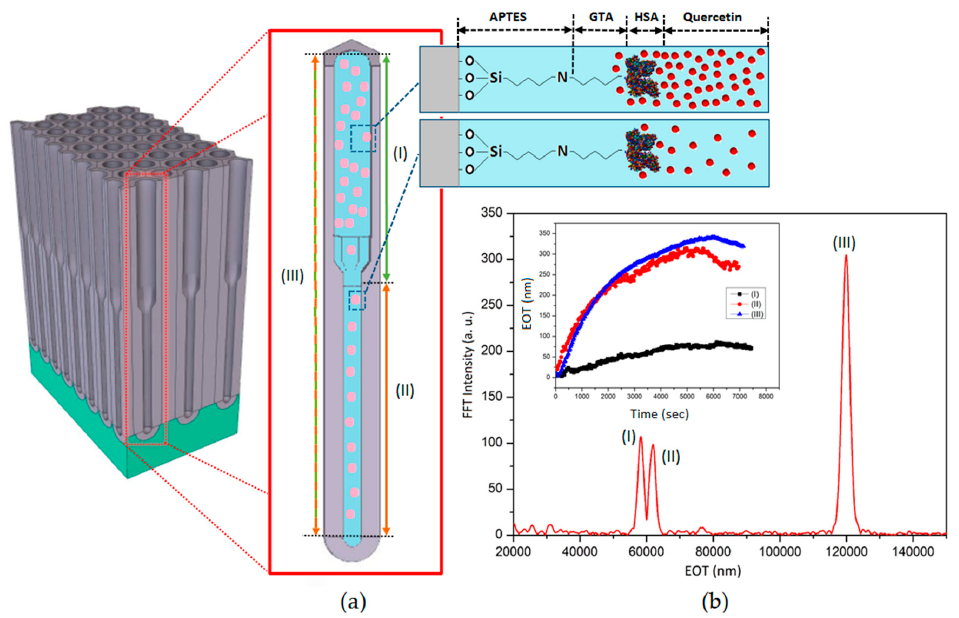
Figure 4. The proposed RIfS sensing concept using BL-NAAs platforms showing changes of EOT signals during surface modification and the preparation of sensing layer (HSA) and sensing analyte molecules (quercetin) showing the binding activity between HSA-modified pore surface and quercetin. ( a ) Schematic illustration of binding event between HSA and quercetin in the environment of fresh PBS (pH = 7.5) in the top and bottom pore layer. BL-NAAs and NAAs were modified with silane molecules before subjecting them to real-time monitoring process; ( b ) typical FFT spectra of BL-NAA (50/50) showing 3 distinguished peaks that are related to two pore layers and used for sensing showing time response RIfS signal that present EOT measurement quercetin (0.375 mM) binding activity in all 3 optical layers simultaneously.